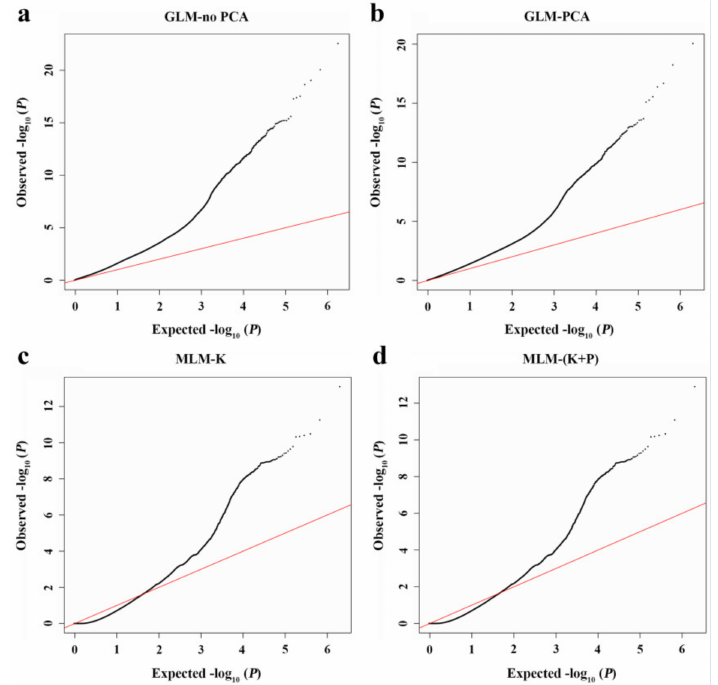
Figure 2. Quantile–quantile (Q–Q) plot of the four analysis models used in the genome-wide association study (GWAS) for peach pollen fertility trait. The red line indicates the expected line under the null distribution. The black line represents the P values observed using the ( a ) GLM-no PCA, ( b ) GLM-PCA, ( c ) MLM-K, and ( d ) MLM-(K+P) models,